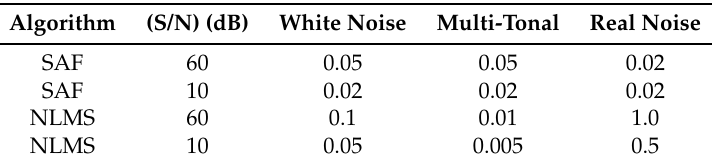
Table 5. Adaptation Step Size Used in test case